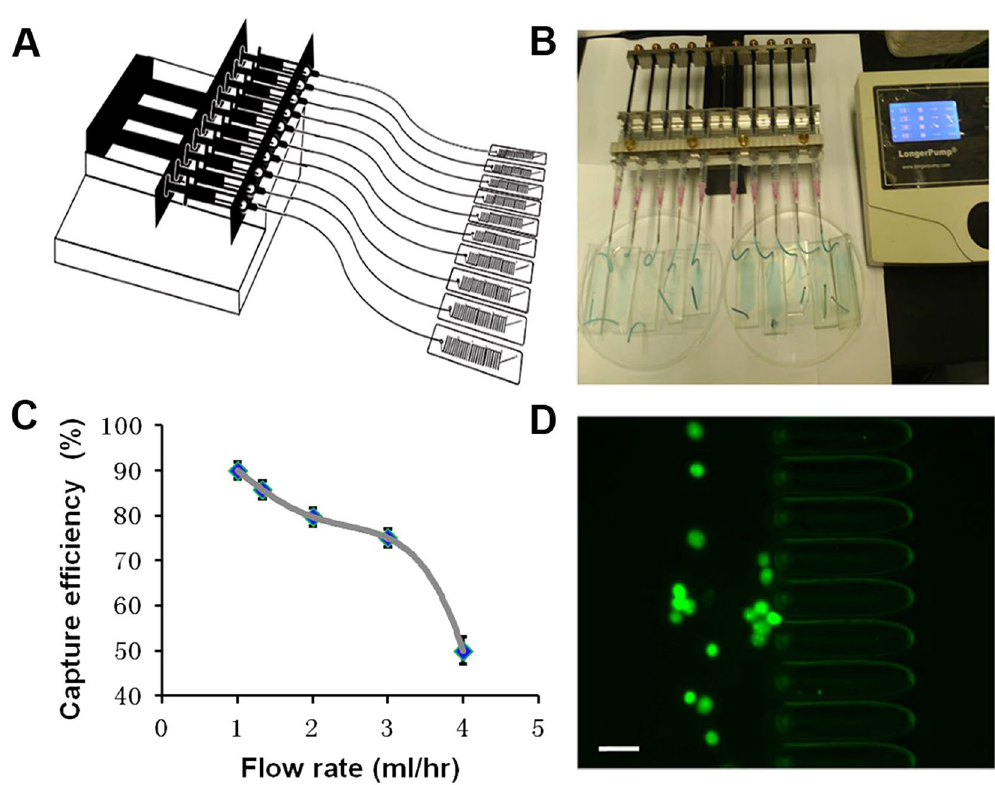
Figure 3. ( A ) Diagram of microfluidic chips connecting to a 10-channel syringe pump. ( B ) Photography of microfluidic system for ultra-sensitive capture of CTCs. ( C ) Capture efficiencies of Ellipse filters at varied flow rates. ( D ) Tumor cells are captured before the micropillars. Scale bar = 50 µ